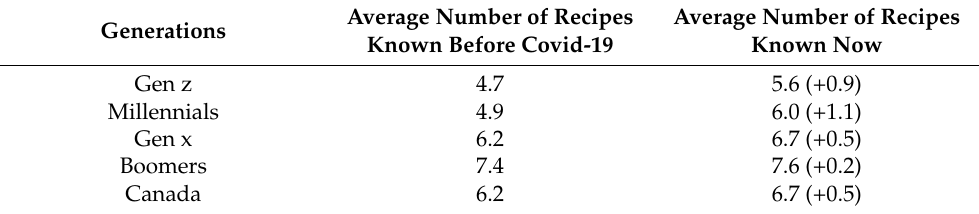
Table 1. Increase in number of recipes